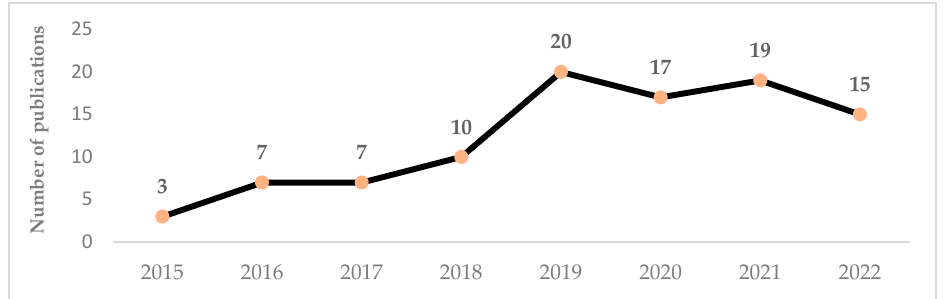
Figure 3. Distributions of articles per year of publication.